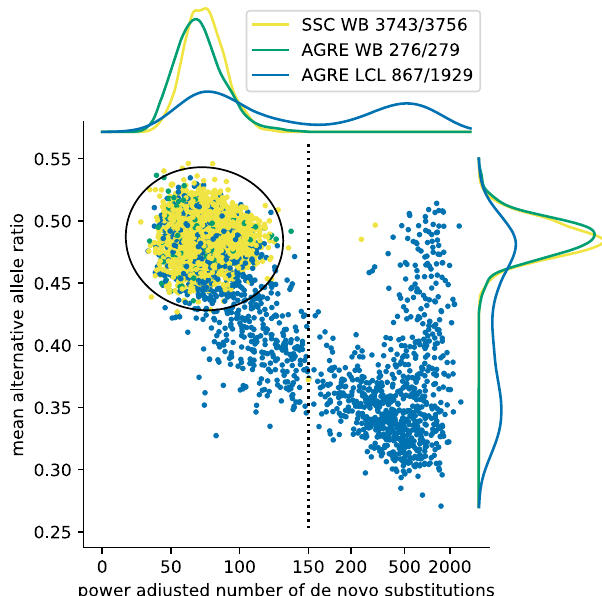
Fig. 1 Cell-line genetic drift fi lter. Each dot represents a data point from one individual child. Individuals from AGRE for which DNA was extracted from LCLs (AGRE LCL) are colored blue, individuals from SSC, for all of which DNA was extracted from whole blood (SSC WB) are colored yellow, and individuals from AGRE extracted from whole-blood DNA (AGRE WB), are colored green. We adjusted the number of observed de novo substitutions based on the power for detection of de novo SNVs estimated separately for every child (see Materials and Methods for description of procedure for power estimation and Supplementary Figure 2). We set the adjusted number of de novo substitutions to the observed number of de novo substitutions divided by the estimated power and show it on the X-axis in linear scale for numbers smaller than 150 (the vertical dashed line) and in log-scale for larger numbers. For every child, we assigned the mean alternative allele ratio based on the alternative allele ratios (de fi ned as the proportion of the sequencing reads converting the position that support the alternative allele) for each of the de novo substitutions identi fi ed in the child. The mean alternative allele ratios are shown on the Y-axis. Density plots in the top and right sides show marginal distributions of corresponding cohorts by color. We modeled the WB data from SSC and AGRE as a two-dimensional Gaussian distribution over the power adjusted number of de novo substitutions and the mean alternative allele ratio and we established an ellipse (shown in black) that would include 99.9% of the Gaussian distribution density. Children within the ellipse are considered free of cell-line genomic drift. We show in the inset the total number of children in each of the three groups together with the number of children that were determined to be free of cell-line genetic